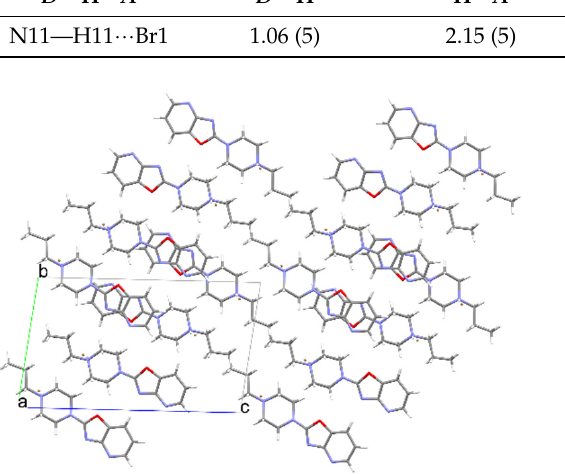
Figure 18. The crystal packing of 6 .